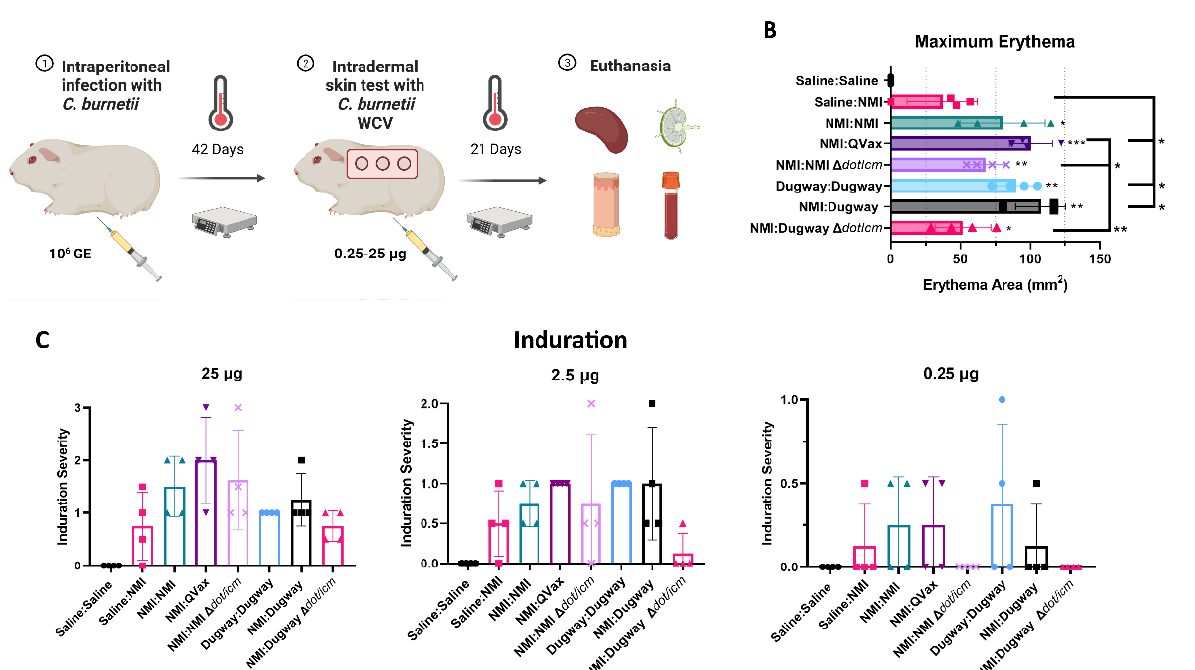
and mesenteric lymph node cellularity (Supplementary Figure S7E) remained unchanged among groups at day 21 post-skin testing.